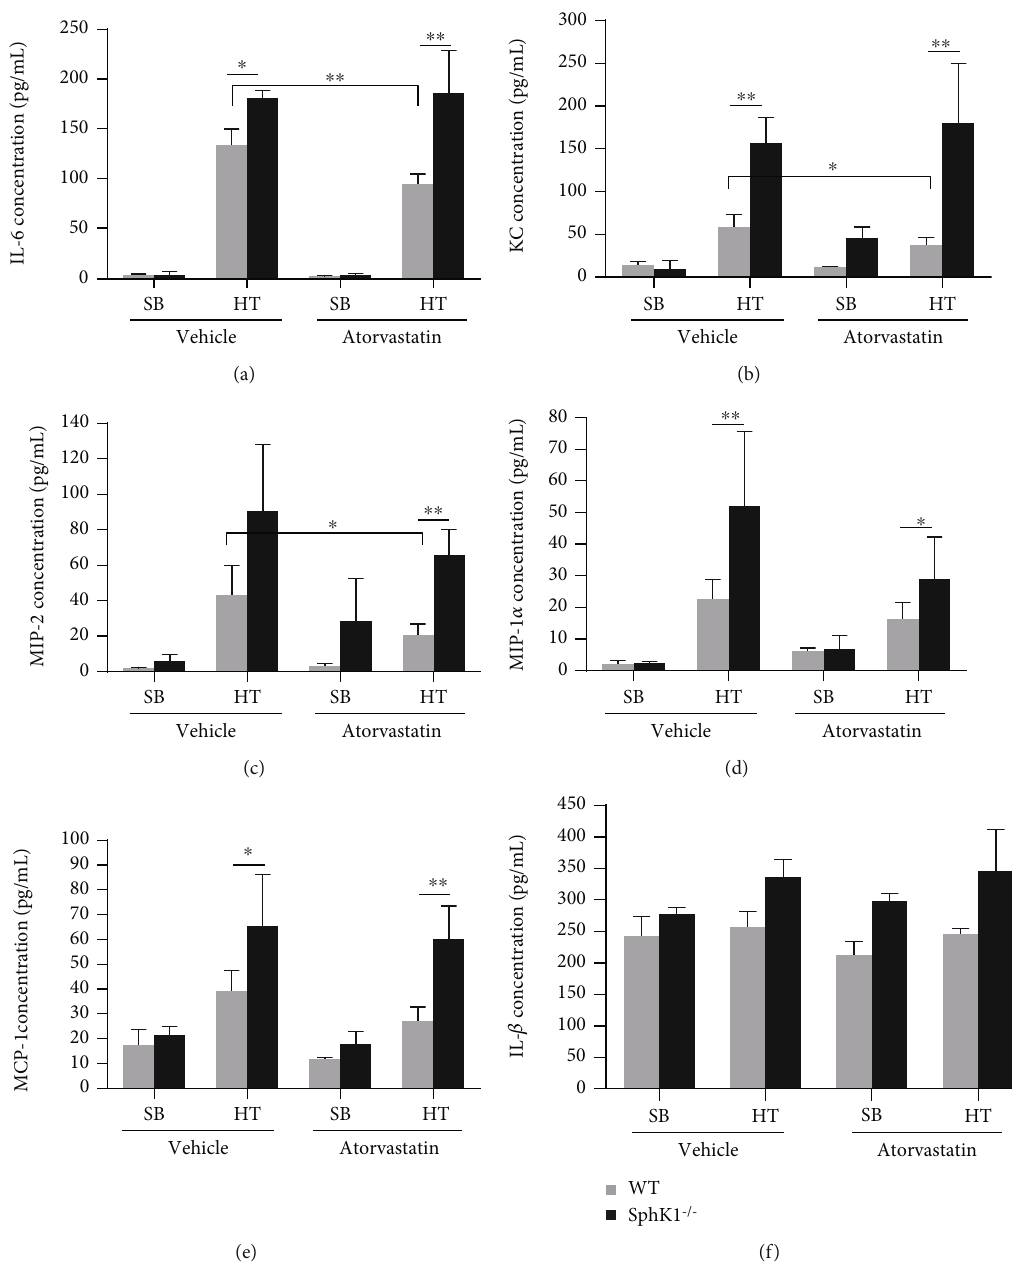
Figure 2: Atorvastatin attenuated HT-mediated cytokine generation in BAL, but SphK1 knockout diminished this e ff ect. ELISA was performed on the BAL harvested from both post-HT WT and SphK1 -/- mice as described in Materials and Methods. Similar with protein and cell in fi ltration, HT signi fi cantly increased cytokine release in WT mouse BAL. These cytokines included IL6, KC, MIP-1 α , MIP-2, and MCP-1, but not IL-1 β . HT-mediated cytokine release in WT mouse BAL was signi fi cantly attenuated by pretreatment of atorvastatin; HT-mediated cytokine generation was signi fi cantly higher in SphK1 -/- mouse BAL than that in WT mice. Moreover, SphK1 knockout reversed the anti-in fl ammatory e ff ect of atorvastatin in cytokine generation ( ∗ P < 0 : 05 , ∗∗ P < 0 : 01 MCP-1 (WT Vehicle/HT vs. WT Atorva/HT, 39 : 26 ± 8 : 22 vs. 27 : 26 ± 5 : 51 pg/ml , P > 0 : 05 , n = 5 ) as WT mice responded to high tidal volume ventilation (Figure 2).